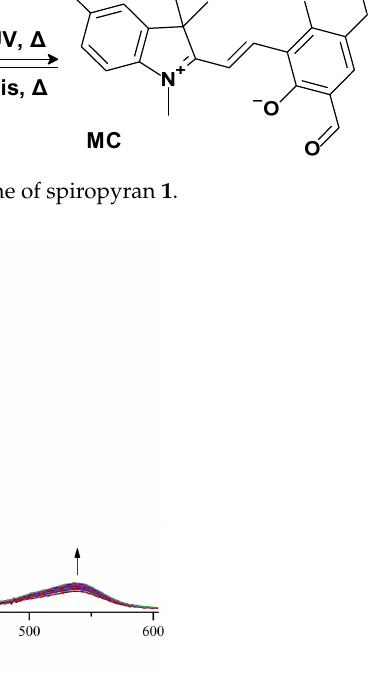
Figure 1. Changes in the absorption spectrum of the compound 1 upon UV irradiation ( λ irr = 313 nm) in acetonitrile, C = 2.18 × 10 − 5 M, T = 293 K.